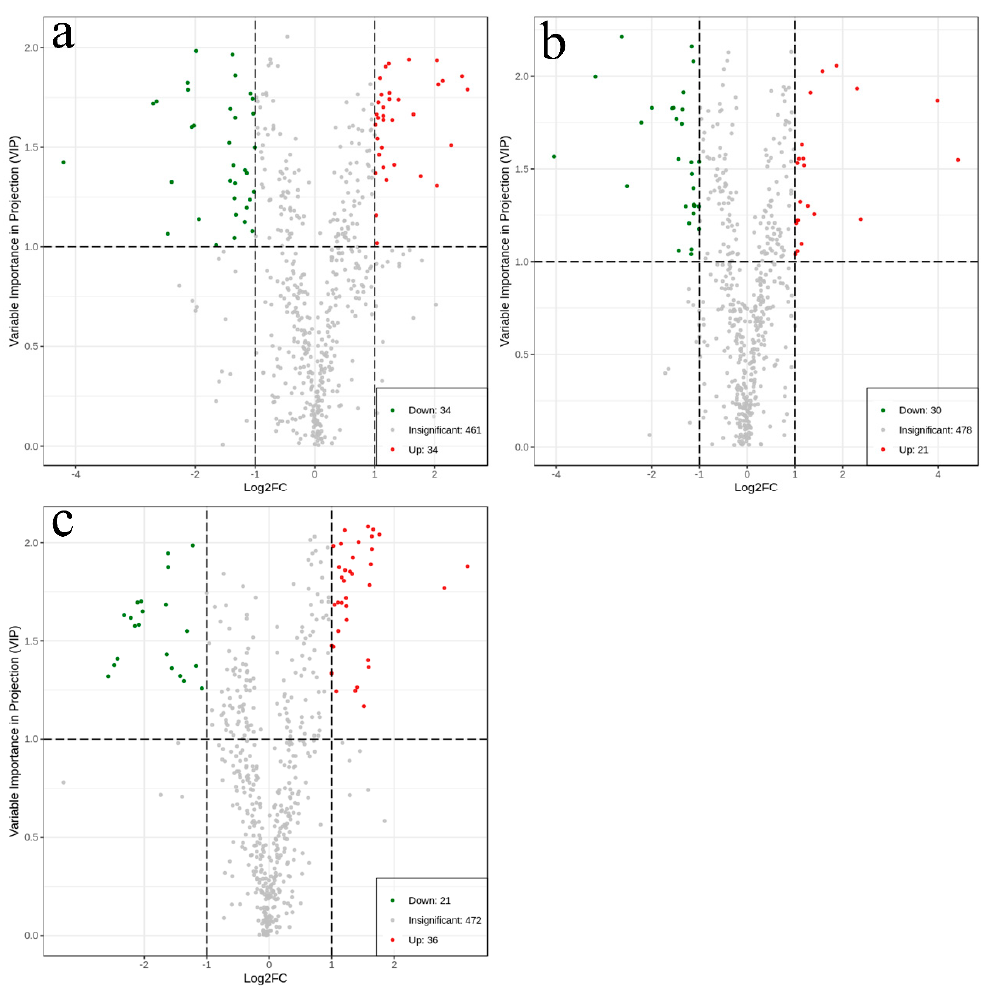
Figure 3. Volcano plots for ( a ) PB vs. PC; ( b ) PB vs. CC; ( c ) PC vs. CC. The green dots in the plots illustrated that the differential metabolites were significant and down-regulated, while the red dots illustrated that the differential metabolites were significant but up-regulated, and the black dots illustrated that the metabolites could be detected in samples but did not have any significant difference.